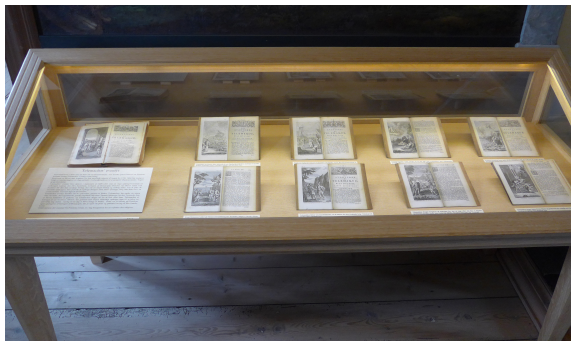
Figure 2. Showcase with an original print from 1726 of the book Les Avantures de Telemaques, Fils d’Ulysse by Francois de Fenelon (1651–1715), together with photographic reproductions of eight selected spreads. Museet på Sønderskov, Brørup, Denmark.